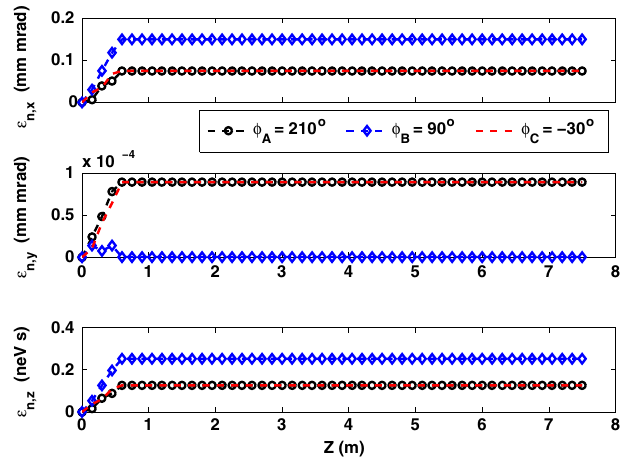
FIG. 12. Evolution of normalized projected rms emittance [ (cid:8) n; ð x;y;z Þ ð z Þ ] corresponding to the rf phases (cid:4) A;B;C along the direction of beam